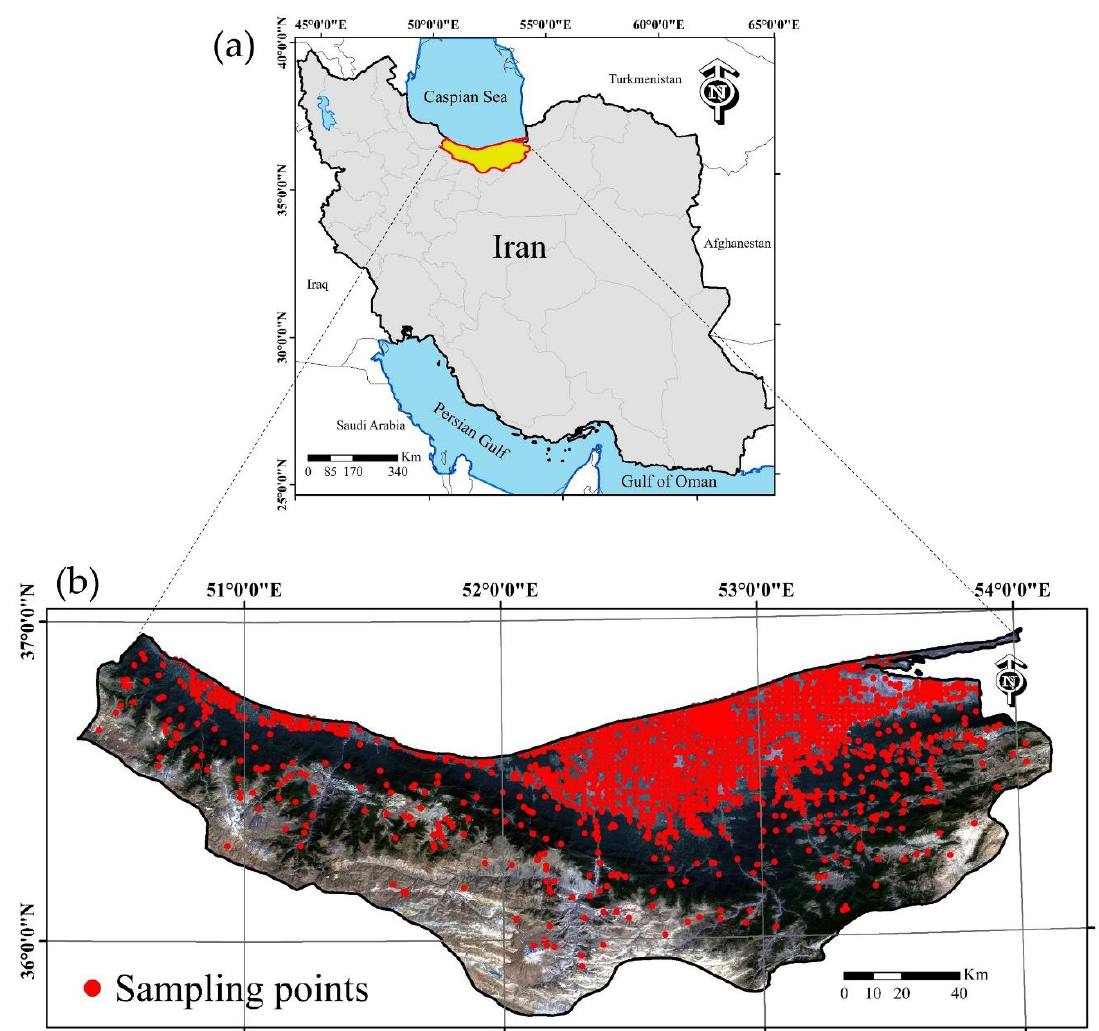
Figure 1. Localization of the Mazandaran province in Iran ( a ); and spatial distribution of soil sampling locations within the Mazandaran Province ( b ).